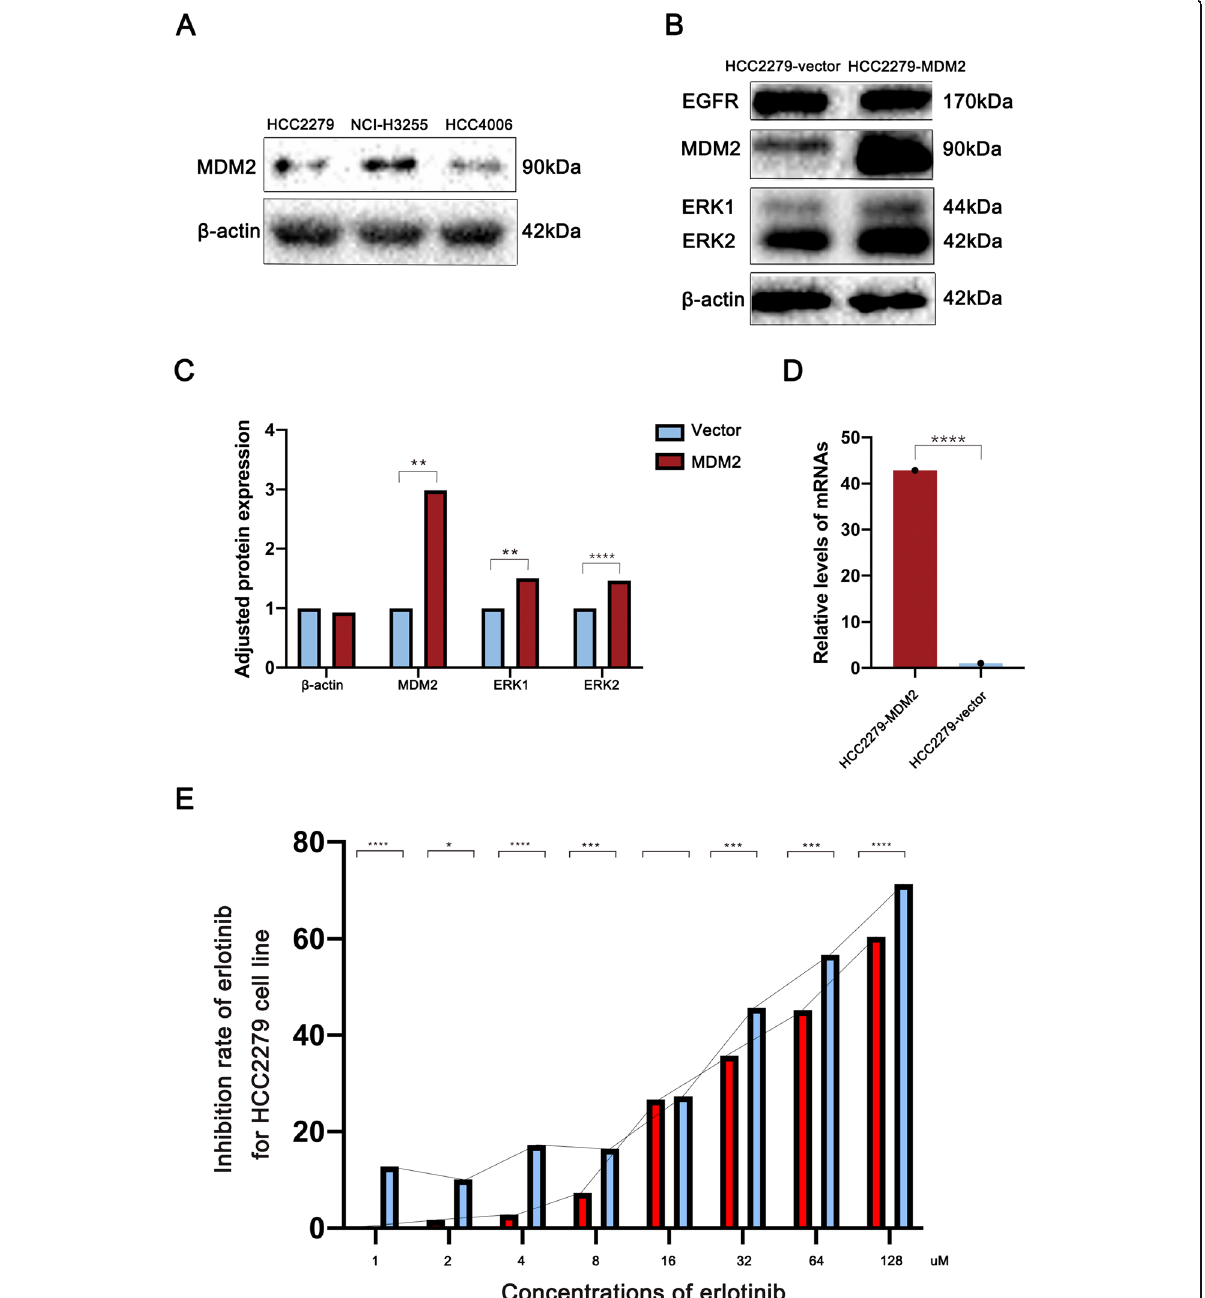
Fig. 2 MDM2 amplification induces the primary resistance to erlotinib. a Western blotting results for the evaluation of MDM2 expression level among NSCLC cell lines: the HCC2279 cell line was selected for the subsequent experiments for the medium expression of MDM2; b Western blotting results for the target proteins in HCC2279 cell line: β -actin is the protein encoded by the house-keeping gene and balances the protein concentrations between 2 groups; MDM2 expression was upregulated after the transfection of the plasmids; EGFR expression demonstrates no significant difference between 2 groups; ERK proteins including ERK1 and ERK2 were all upregulated in HCC2279-MDM2 group; c Quantified results for western blotting; d The verification of transfection in HCC2279 cell line: the transcription level of MDM2 gene was highly upregulated in HCC2279-MDM2 group; e The curve of the inhibition rate after exposure to erlotinib with different concentration through the examination of MTT assays in the MDM2 amplification group and vector control group of HCC2279 cell line: 10uM erlotinib was set as the medium concentration in this experiment, dramatic resistance to erlotinib could be found in HCC2279-MDM2 group in 1uM, 2uM, 4uM, 8uM, 32uM, 64uM and 128uM erlotinib. The inhibition rates were measured via the formula as follow: Inhibition rate=1-[(A570-A630) of treated cells/(A570- A630) of control